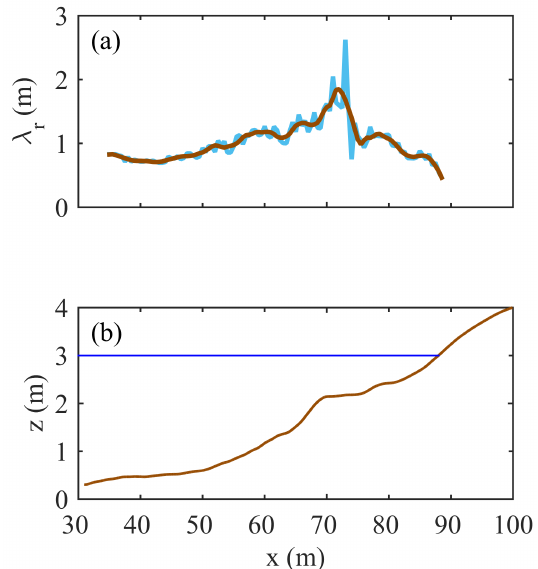
Figure 2. ( a ) Ripple length λ versus cross-shore distance x after wave run 5 in test A4. r The blue line represents the original values based on the 10-m wide windows; the brown line = 3 . 5 m smoothed version; ( b ) shows the bed profile at the end of this wave run for is the l x = 3 m. reference. The horizontal blue line is the still water level h s